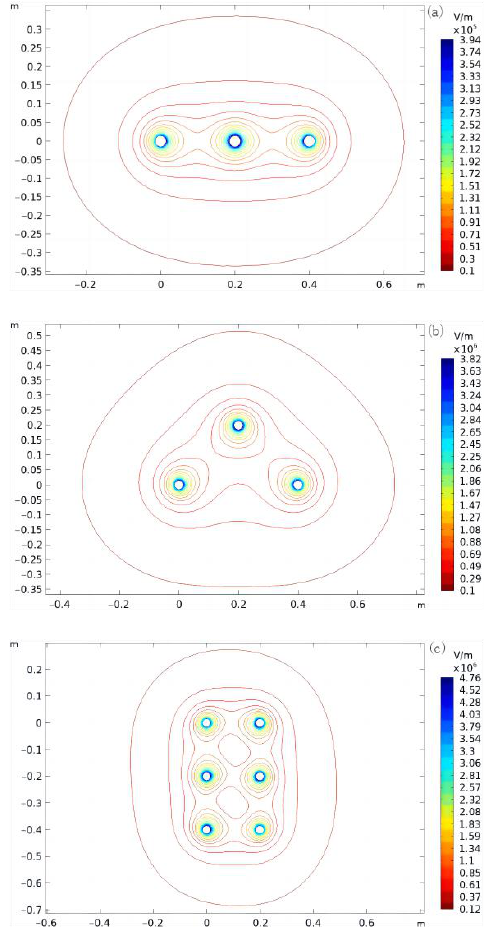
Figure 20. Arrangements of three-phase wires with different distributions: ( a ) horizontal; ( b ) triangular; ( c ) dual-round.